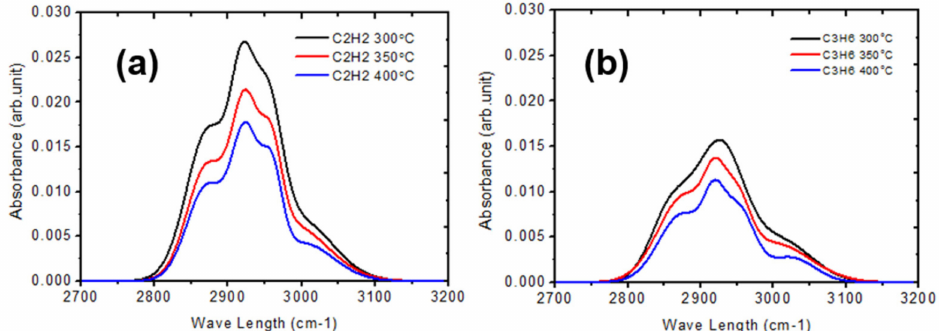
Figure 3. FTIR spectra of ACHM with different source of ( a ) C 2 H 2 and ( b ) C 3 H 6 at 300 ◦ C, 350 ◦ C and 400 ◦